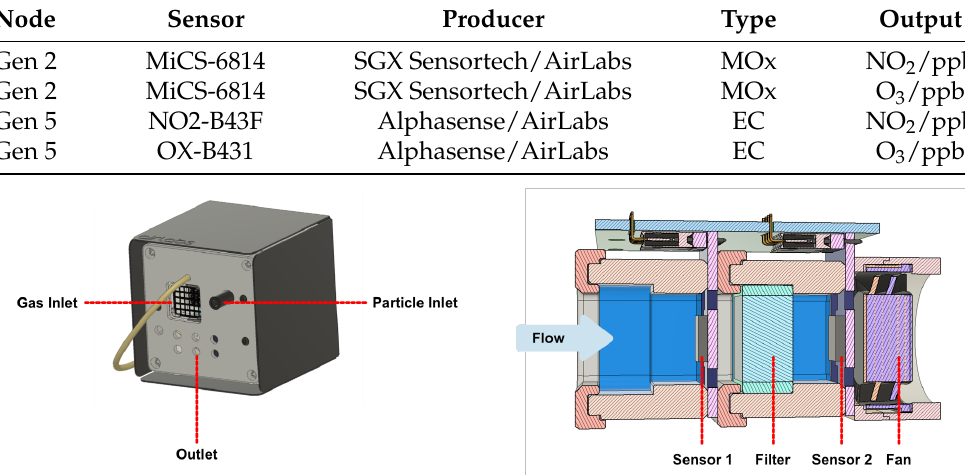
Figure 1. AirNode Gen 2 ( left ) and cross-section of the AirNode Gen 2 gas sampling system, showing both of the MOx cells in series, the filter between them, and the fan behind them ( right